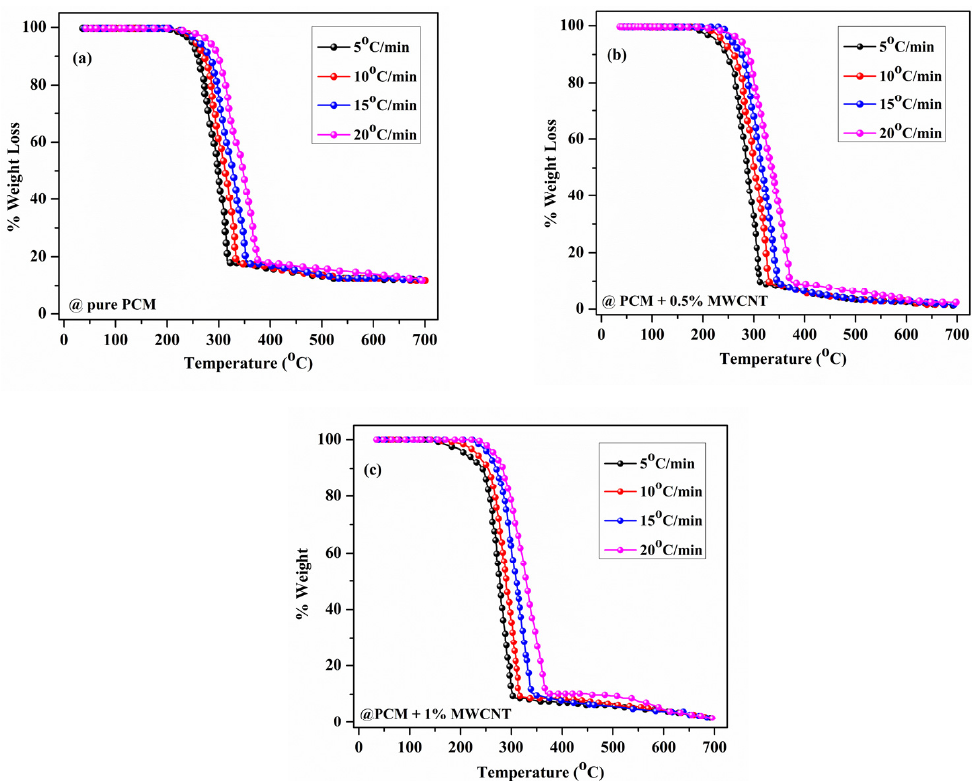
Figure 4. TGA plots ( a ) pure PCM ( b ) PCM + 0.5% MWCNT ( c ) PCM + 1% MWCNT.